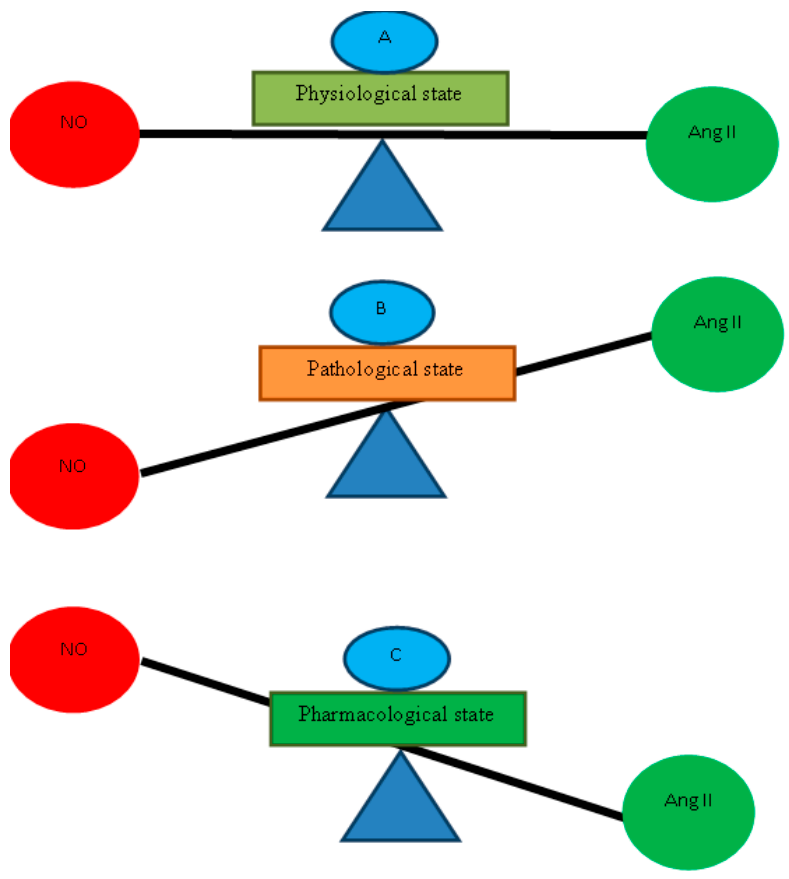
LVH, while ( C ) indicates that pharmacological treatment with NO donors or Ang II inhibitors increases the NO and reduced the levels of Ang II to offset the pathological